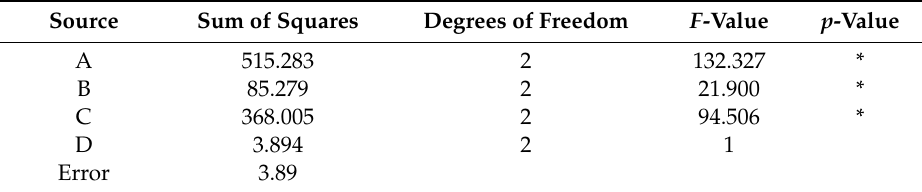
Table 3. Analysis of variance (ANOVA) for the orthogonal test.